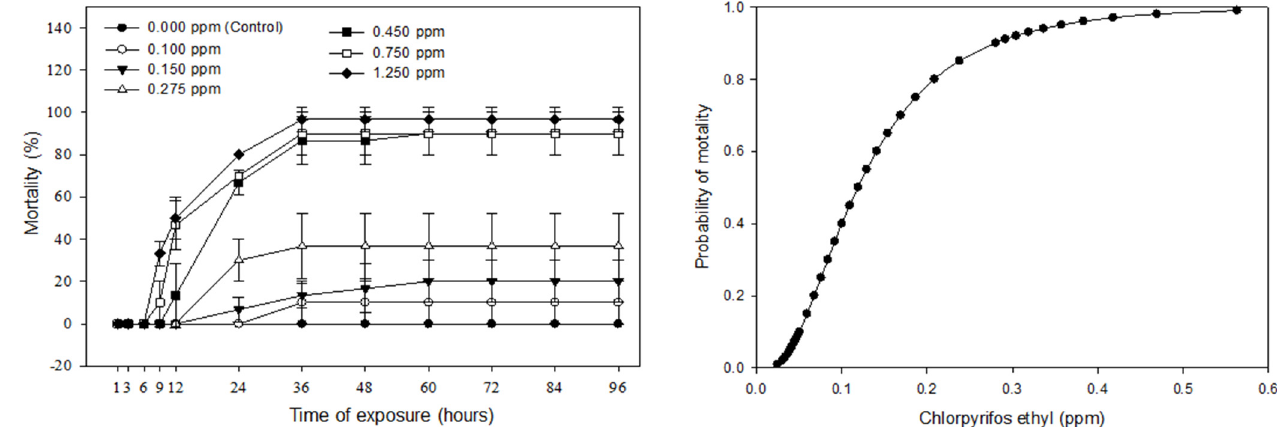
Figure 1. Mortality responses to exposure doses ( left ) and relationship between concentration of chlorpyrifos ethyl and mortality probability at 96 h ( right ).